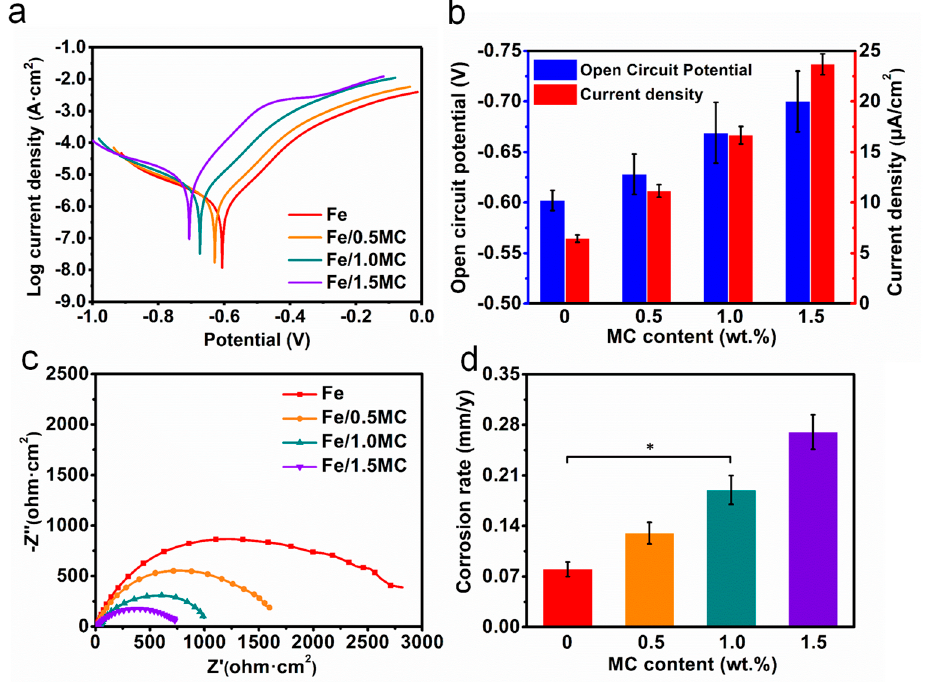
Figure 5. ( a ) The potential polarization curve; ( b ) The obtained E corr and I corr from Tafel extrapolation; ( c ) The typical Nyquist diagram for the alternating current impedance measurements; ( d ) Corrosion rates calculated from the electrochemical results. n = 3, *p ˂ 0.05.